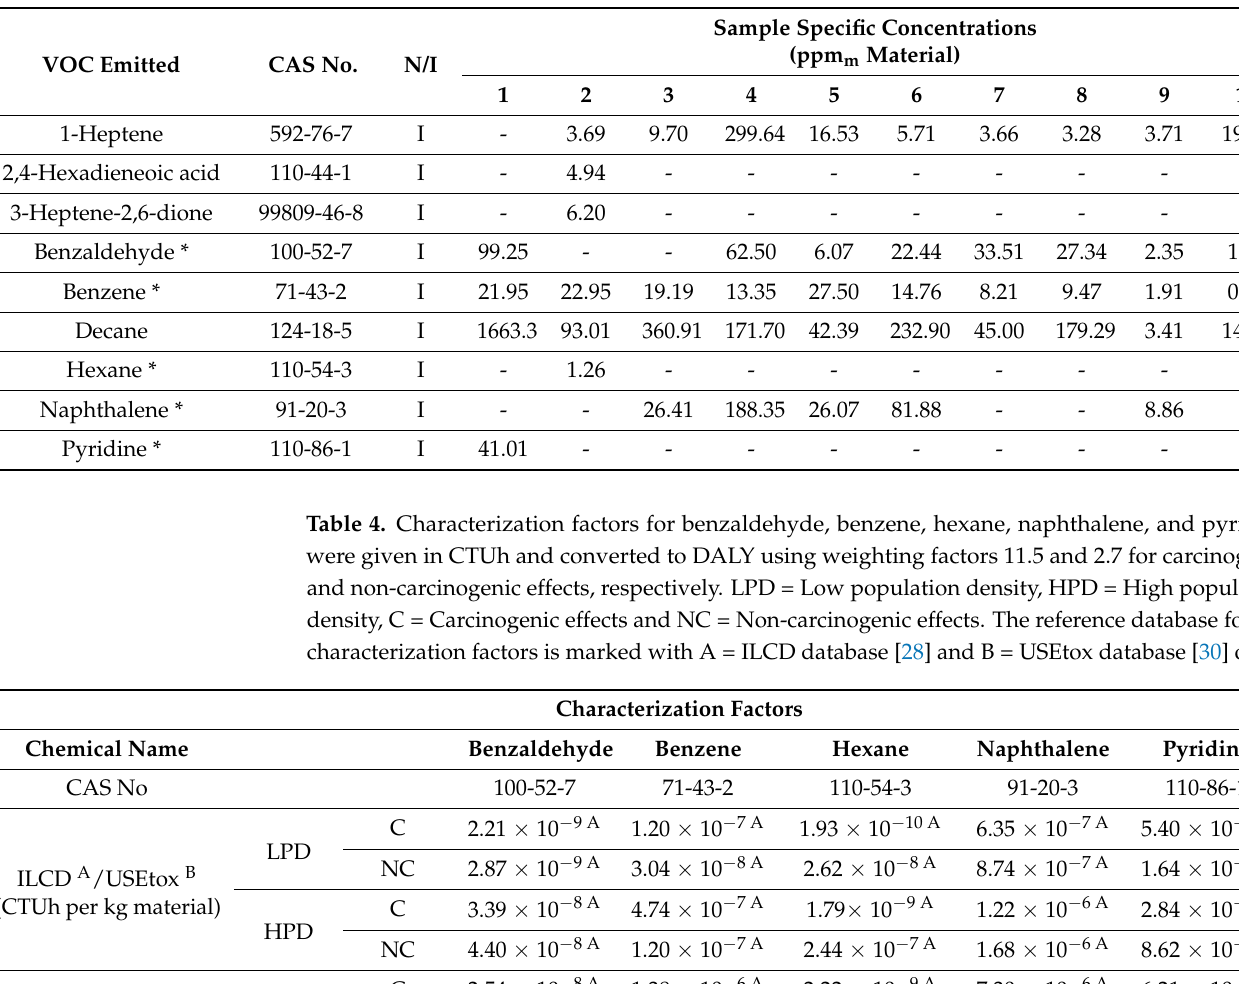
Table 3. Identified VOCs emitted from 10 samples of recycled concrete, with CAS no., origin (N = naturally occurring/I = incorporated chemical) and concentration in ppm m . * denotes the characterized chemicals.